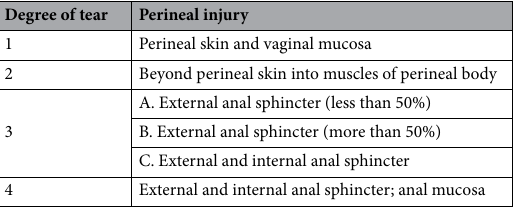
Table 4. World Health Organization (WHO) classification of perineal tears. Grades 3–4 are regarded as obstetric anal sphincter injury